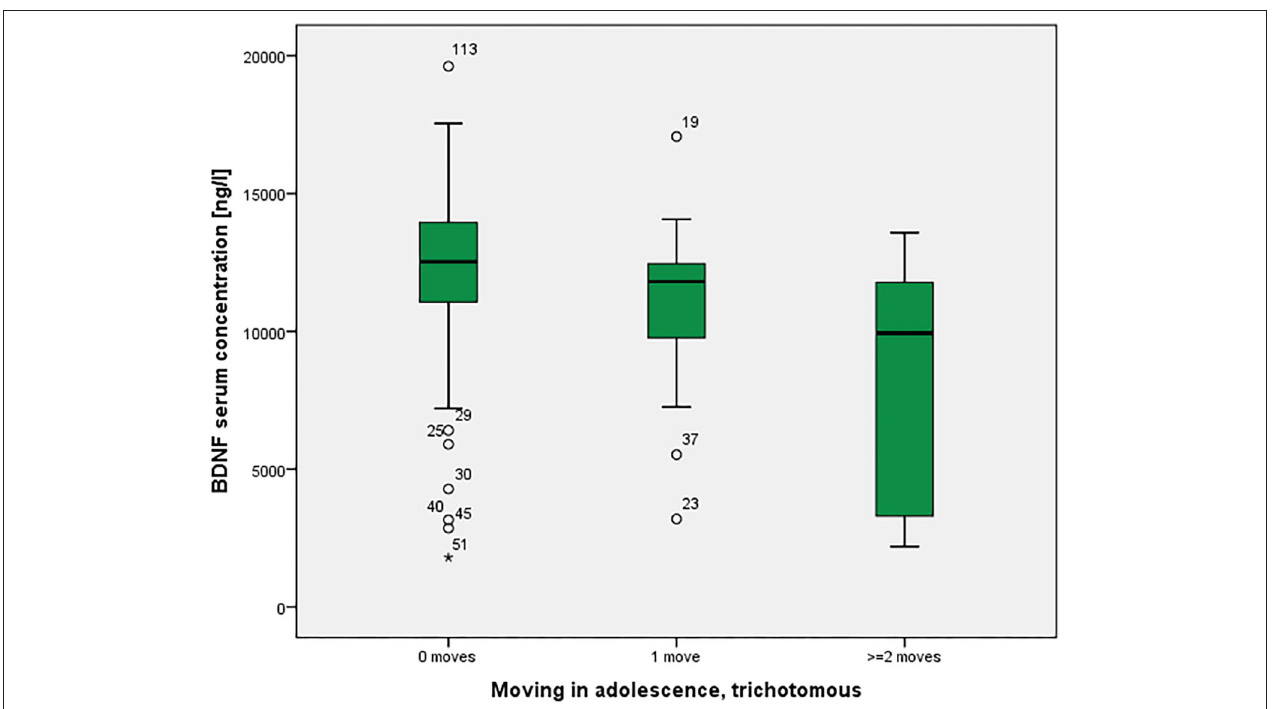
FIGURE 3 | Residential mobility in adolescence and Brain-Derived Neurotrophic Factor (BDNF) in the serum. Boxplot for the group comparison in serum BDNF concentration (ng/l) between subjects who did not move during adolescence (M = 12.0, SEM = 0.4, n = 74) with subjects who moved one time (M = 11.0, SEM = 0.7, n = 21) and twice or more than twice (M = 8.3, SEM = 1.3, n = 11). The ANOVA for simultaneous 3-group comparison is significant ( p uncorrected = 0.007, with Bonferroni-Holm correction p = 0.021). Uncorrected post-hoc Tukey tests showed a significant result for zero moves vs. two or more moves ( p = 0.002), but not for the other comparisons (zero with one: p = 0.481; one with two or more: p = 0.072).